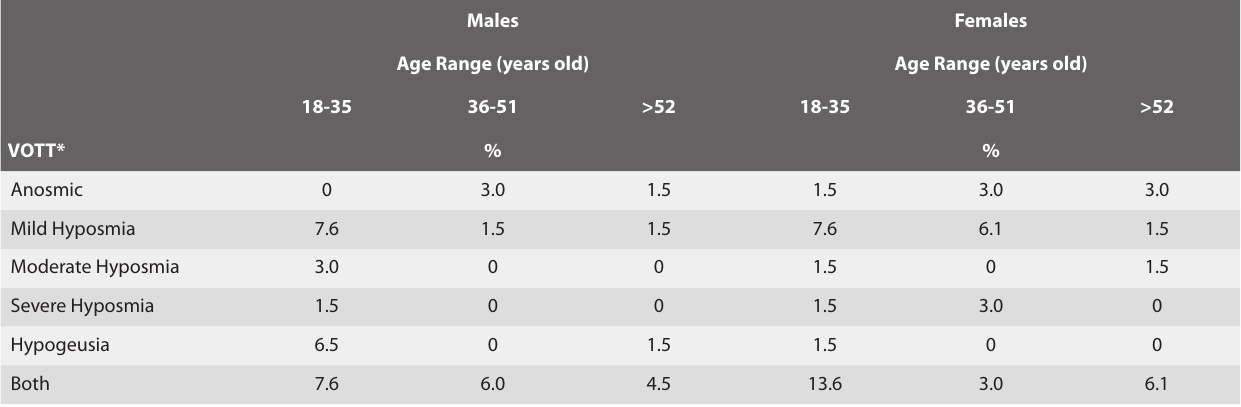
Table 6. VOT+ and taste + by age and